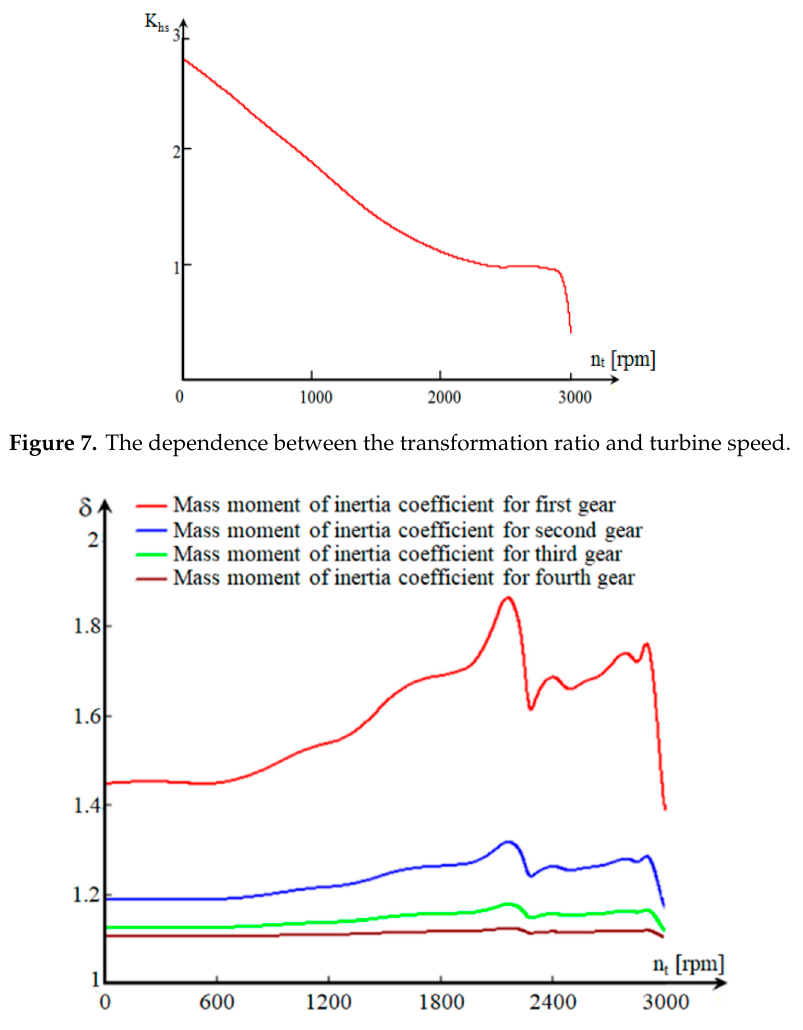
Figure 9. Variation of the mass moment of inertia coefficient depending on the speed of the vehicle.